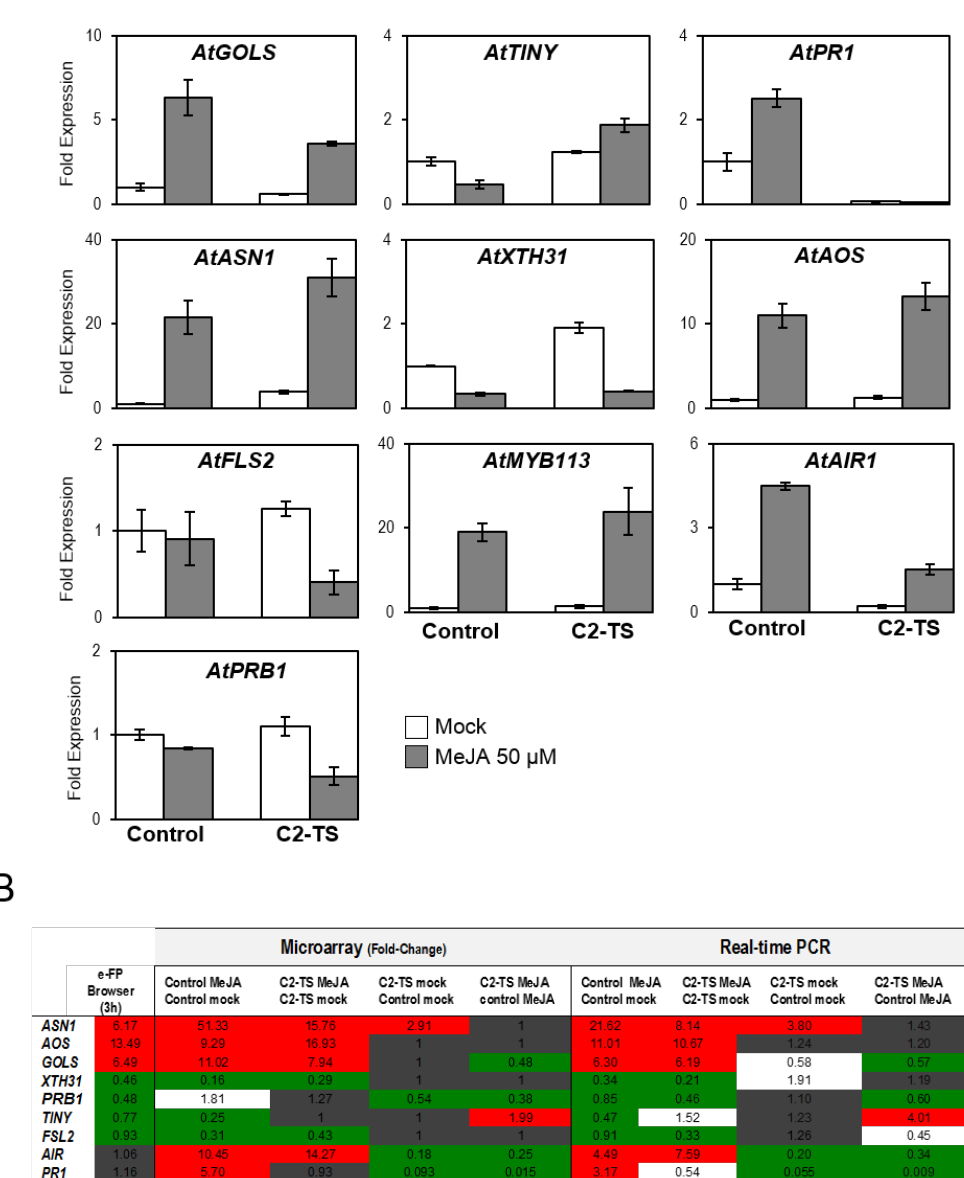
Figure A2. Expression levels of JA-regulated and control genes in Arabidopsis transgenic C2-TS and control plants for microarray validation. ( A ) Relative expression level of AtASN1 (At3g47340), AtAOS1 (At5g42650), AtGOLS (At2g47180), AtXTH31 (At3g44990), AtPRB1 (At2g14580), AtTINY (At5g25810), AtFLS2 ; (At5g46330), AtAIR1 (At4g12550) and AtPR1 (At2g14610) genes in transgenic C2-TS and control Arabidopsis seedlings, mock- or MeJA-treated, determined by real-time PCR. Values are the mean of three technical replicates. Bars represent standard error; ( B ) Comparison between microarray and real-time PCR expression data of the MeJA-regulated and control genes in Arabidopsis transgenic C2-TS and control plants used in ( A ). Up- and down-regulation are shown in red and green, respectively; lack of differential expression or coincidence between the two methods are shown in grey and white, respectively. Values from eFP browser after 3 h of JA treatment are also represented [52] (Arabidopsis eFP Browser. Available online: http://bar.utoronto.ca/efp/cgi-bin/efpWeb.cgi). The numbers represent the expression value in fold change.